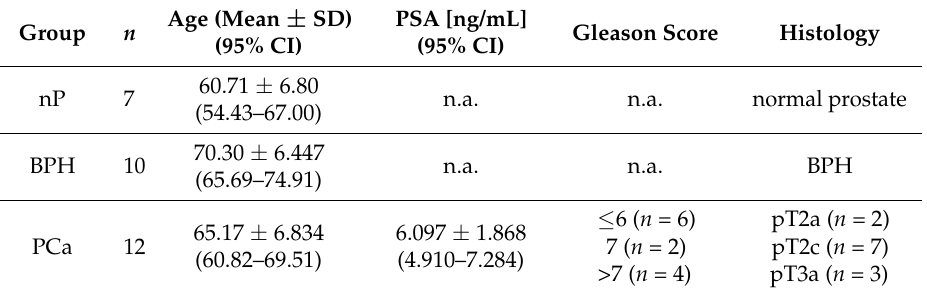
Table 2. Characteristics of patients used for qPCR